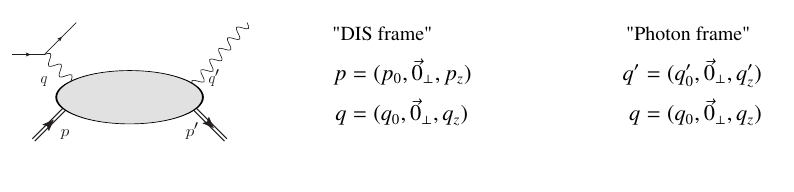
is essentially an electromagnetic background. The blue curve shows the leading-twist result in the “DIS frame” using the GK12 GPD model [54]. The green curve includes in addition the kinematic power corrections t / Q 2 and m 2 / Q 2 . This curve is very close numerically to the leading-twist result in the “photon frame”, see [51]. One sees that the di ff erence is quite